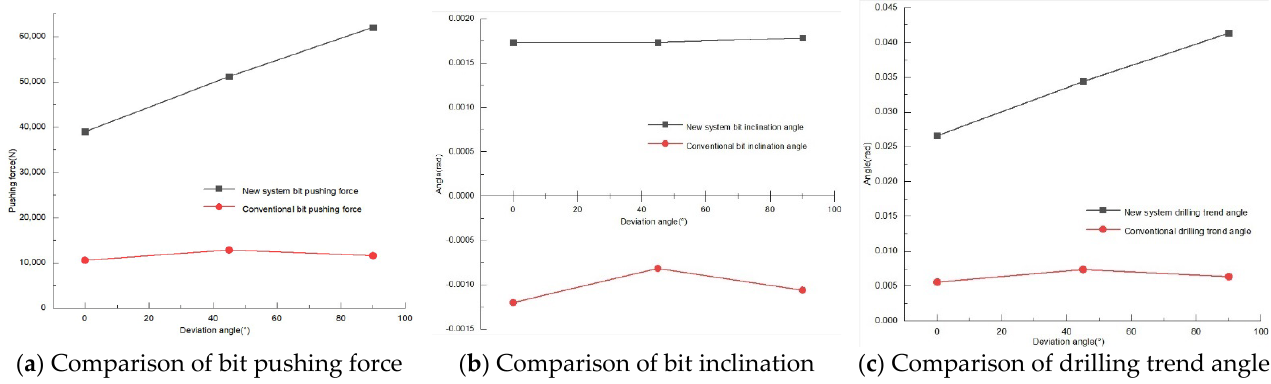
Figure 11. Comparison of trajectory control ability of two kinds of steerable systems.